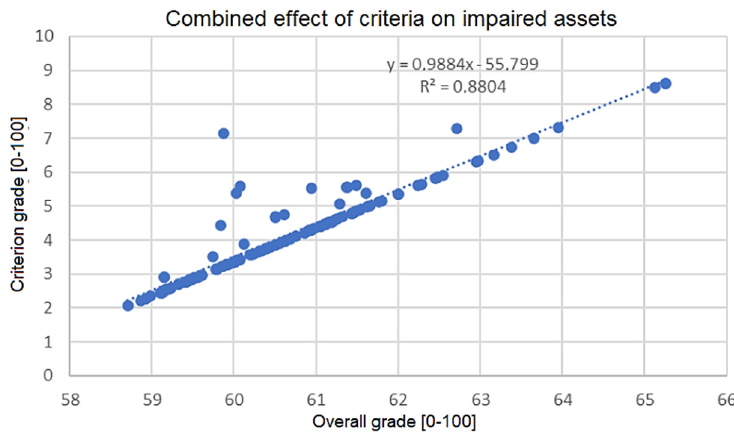
Figure 12. Dispersion of assets when evaluated combined criteria [authors].